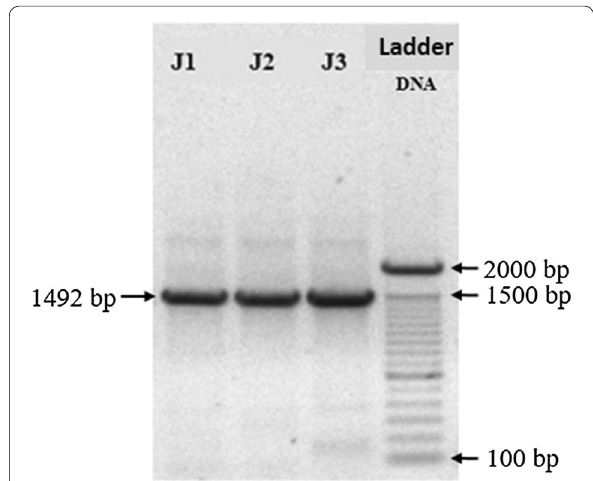
Fig. 2 1% agarose gel used to show the 1492 bp bands found in abscess of three animals (J1, J2 and J3) naturally infected by Corynebacterium